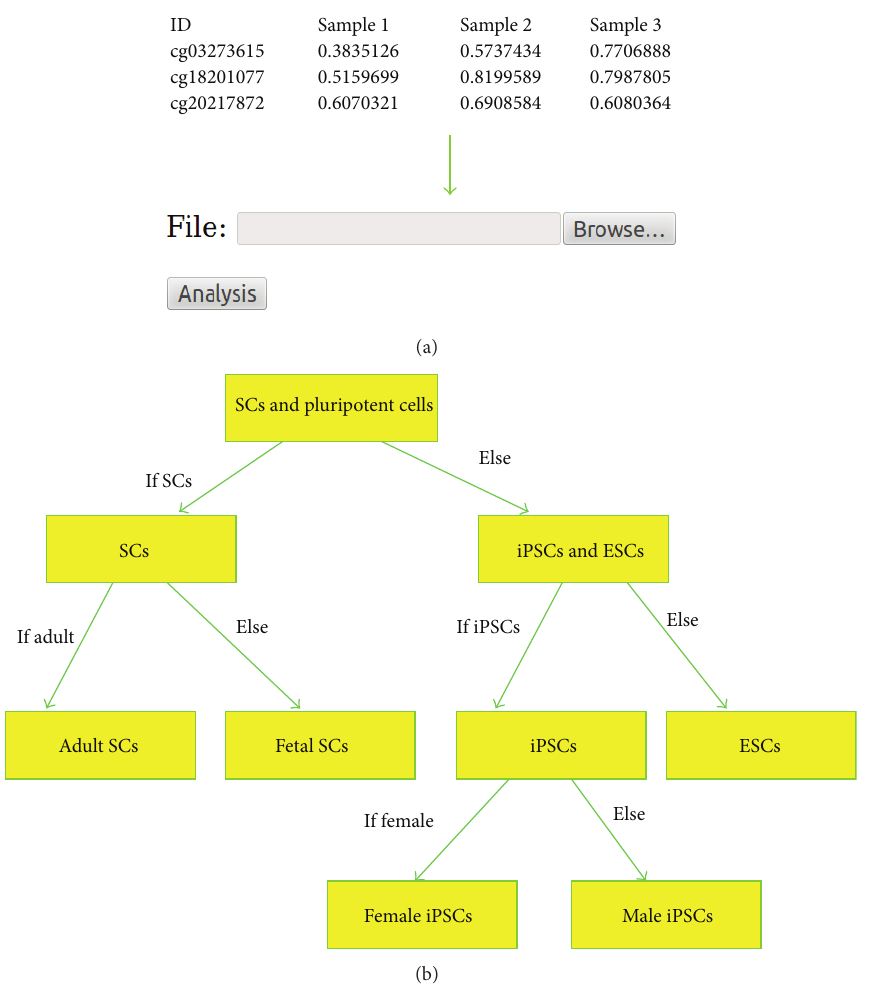
Figure 1: Overview of WCTDS. WCTDS provides a web interface to submit the testing data and to display an example of results and to download the entire result in a zip file. (a) After browsing the input data and clicking the analysis icon provided by the web interface, WCTDS takescareofallcomputationalprocessesautomaticallyunderLinuxshellbehindthewebinterface.Anexampleofsubmitteddataframeformat and the submission form were shown. (b) Many steps are involved in cell type discrimination. The pseudocode highlights the algorithm and discrimination processes in